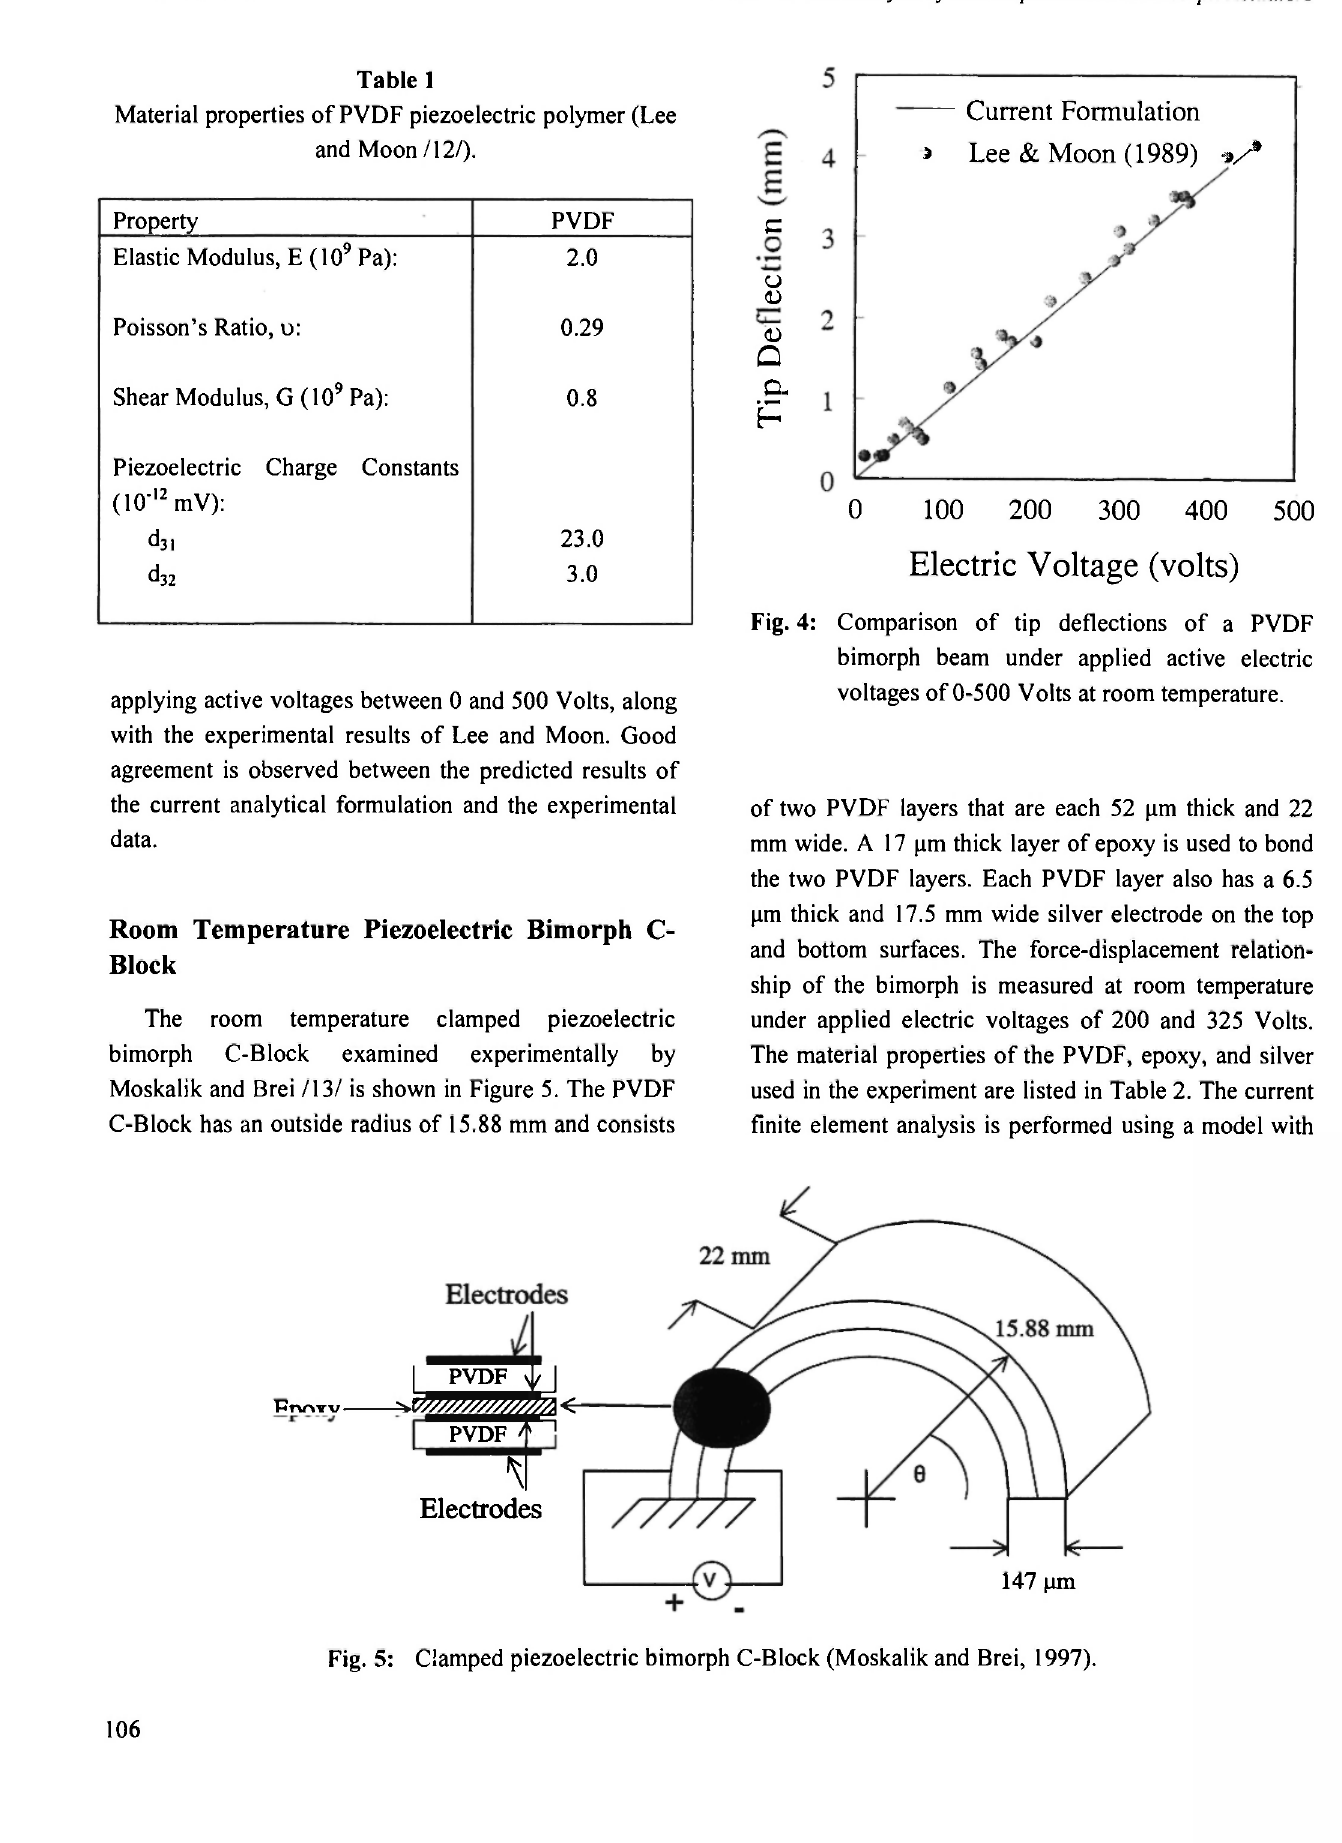
Material properties of PVDF piezoelectric polymer (Lee